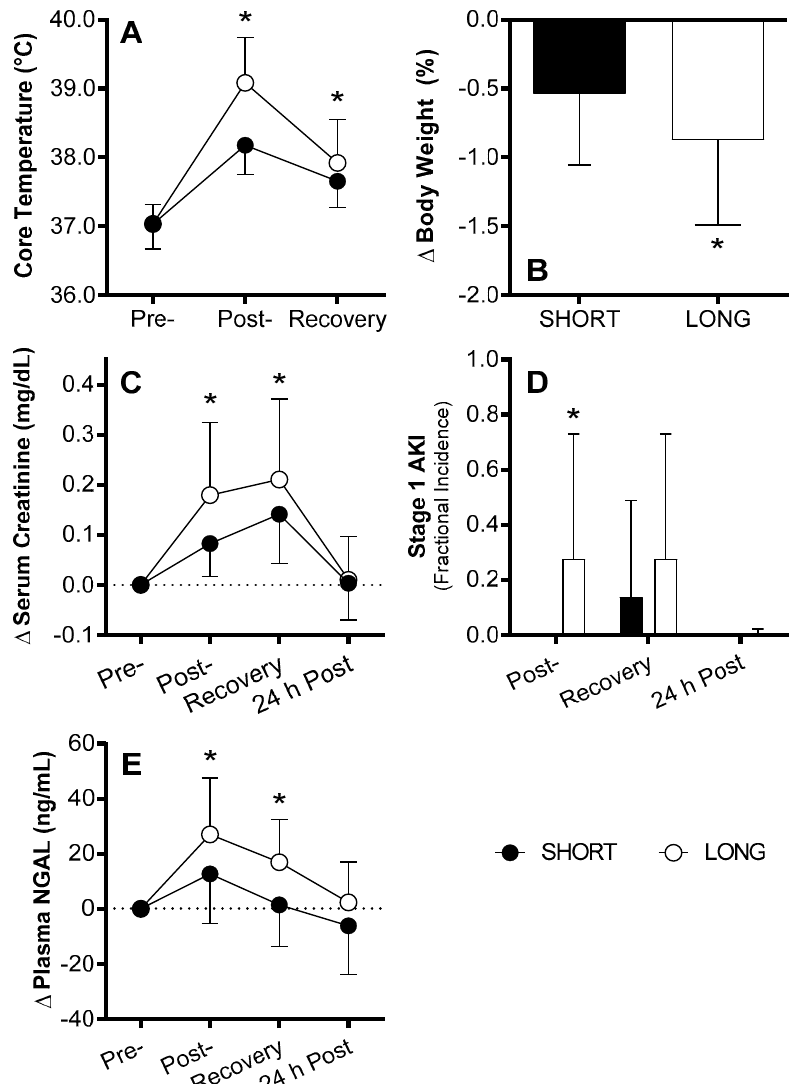
Figure 3. During the longer of two bouts of exercise in the heat (LONG vs. SHORT), greater heat strain ( A ) and dehydration ( B ) resulted in greater changes ( ∆ ) in serum creatinine ( C ), which were sufficient to satisfy the criteria for Stage 1 acute kidney injury (AKI) in ~30% of the subjects ( D ), and greater increases in plasma neutrophil gelatinase-associated lipocalin (NGAL) ( E ). * different from SHORT ( p < 0.05), Mean ± SD, n = 29. From Schlader et al. [29] with permission.